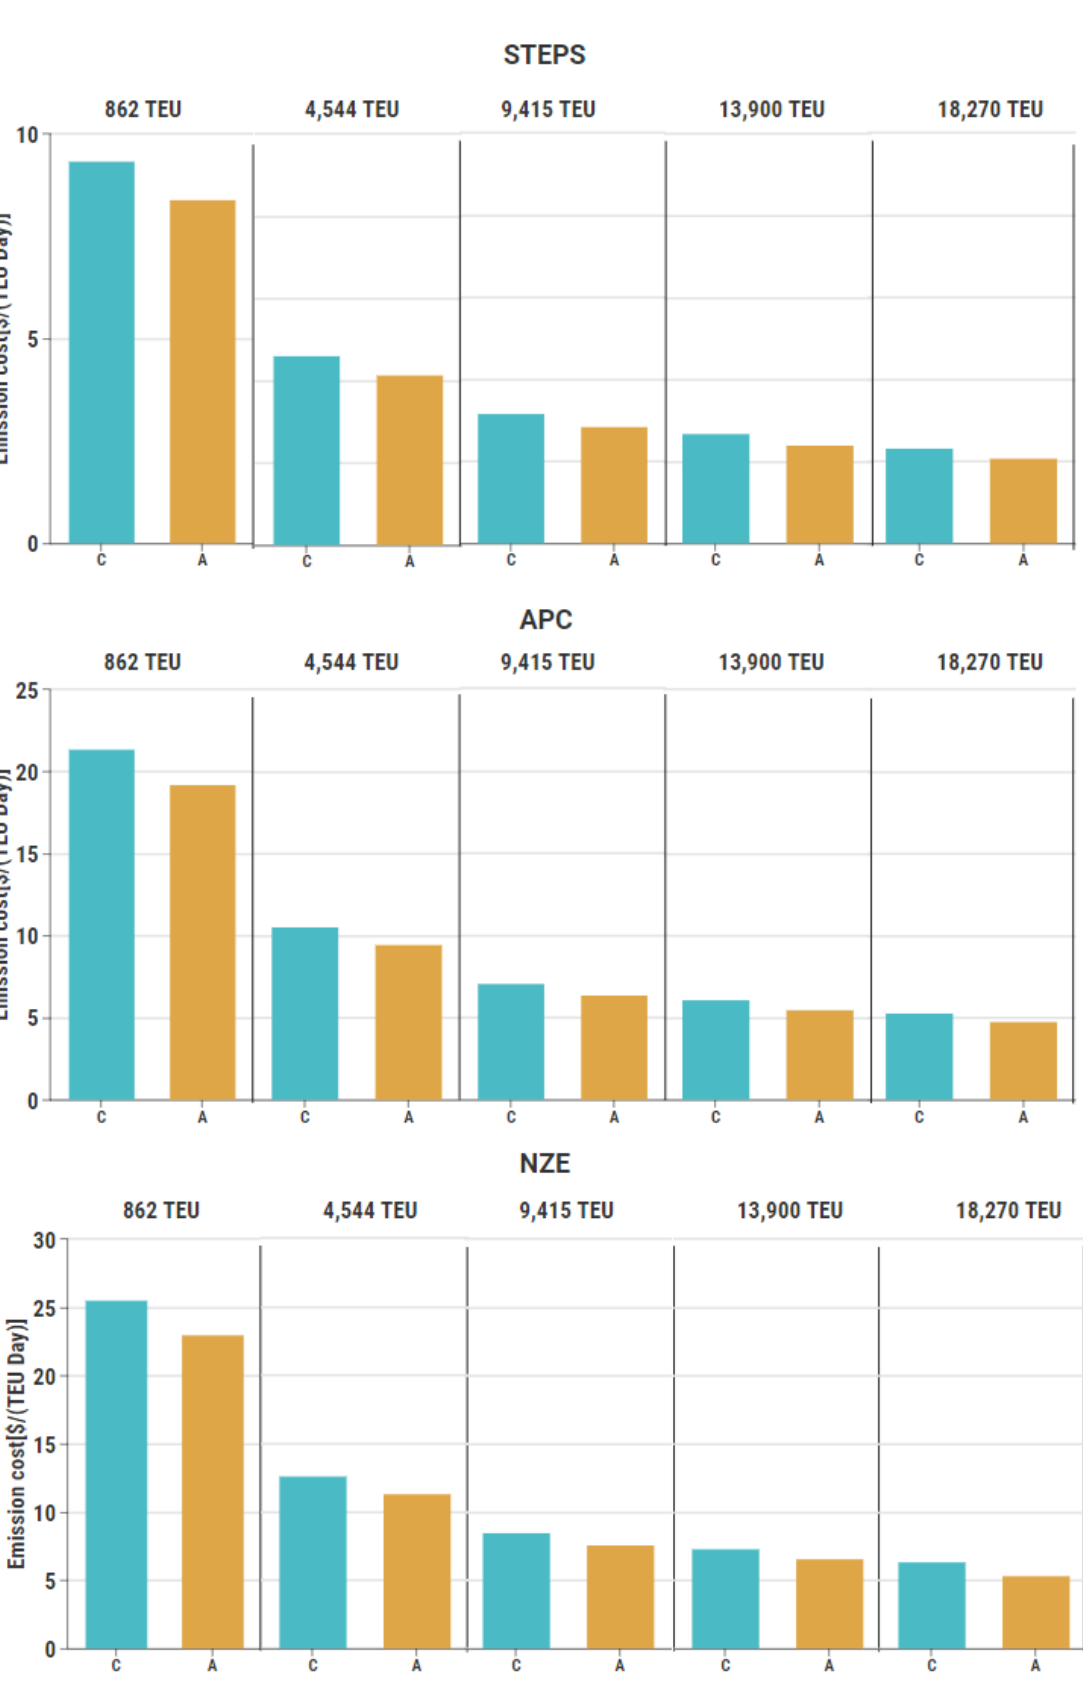
Figure 7. Daily emission costs per container for STEPS, APC, and NZE scenarios for the year 2040.